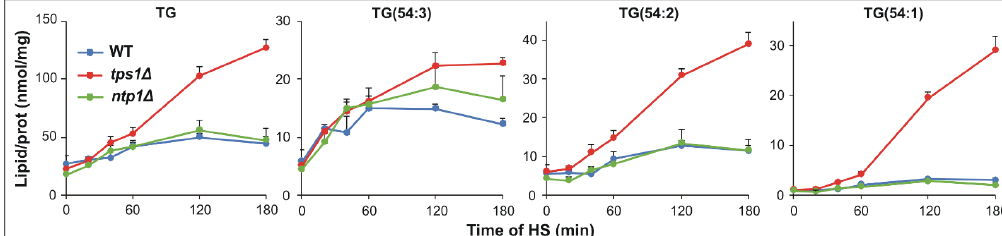
Figure 6. Triglyceride synthesis in heat-stressed S. pombe cells. Yeast cells were heat-stressed at 40 °C for 0–180 min. Kinetics of TG as well as major TG species are shown. Data are presented as mean ± SD, n = 3 (independent experiments); for significance values, see Table S4. WT, wild-type; tps1 Δ , trehalose-deficient; ntp1 Δ , trehalase-deficient S. pombe strains; TG, triglyceride.